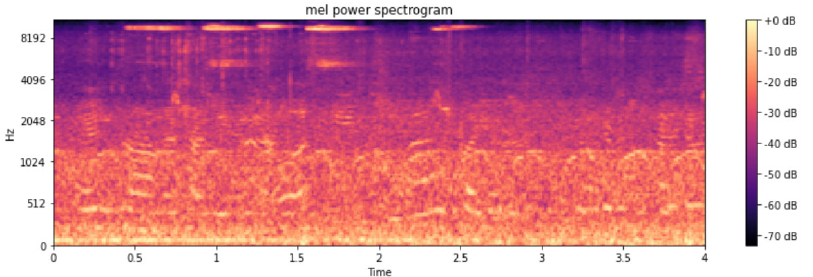
Figure 7. Concrete pouring sound data at a construction site: mel power spectrogram.